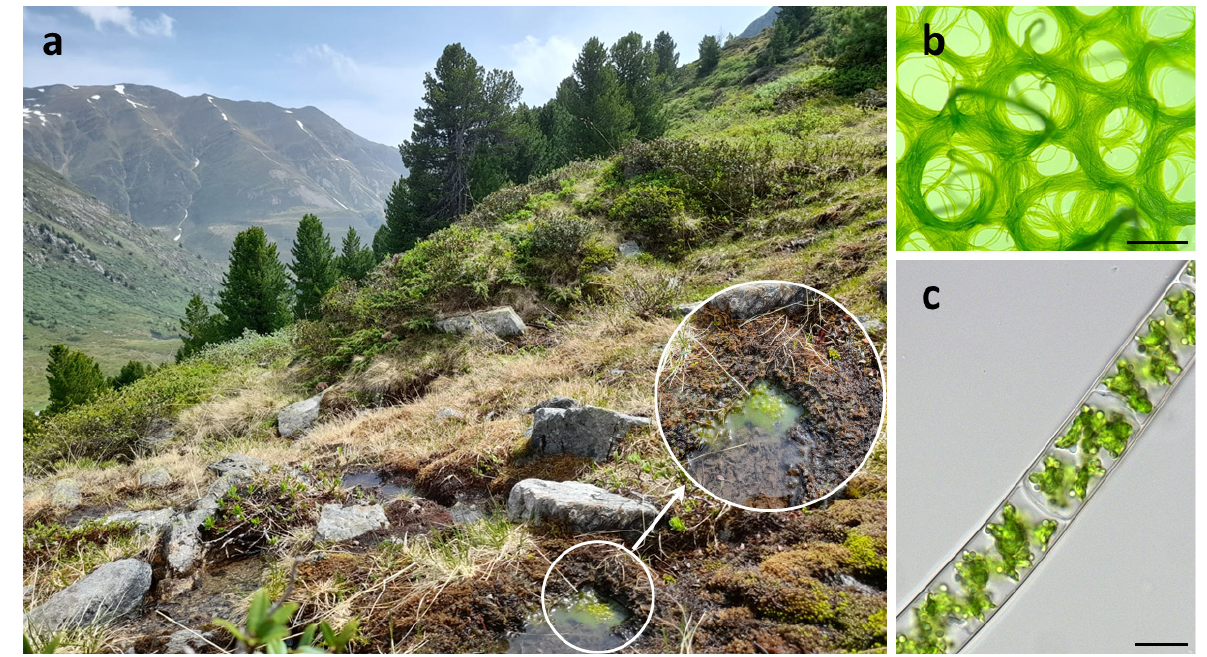
Figure 1. Habitat of isolated Spirogyra mirabilis : ( a ) sampling site with zygnematophycean green algal mat, ( b ) isolated unialgal culture, ( c ) detailed view of vegetative filament. Scale bars ( b ) 1 mm, ( c ) 20 µm .